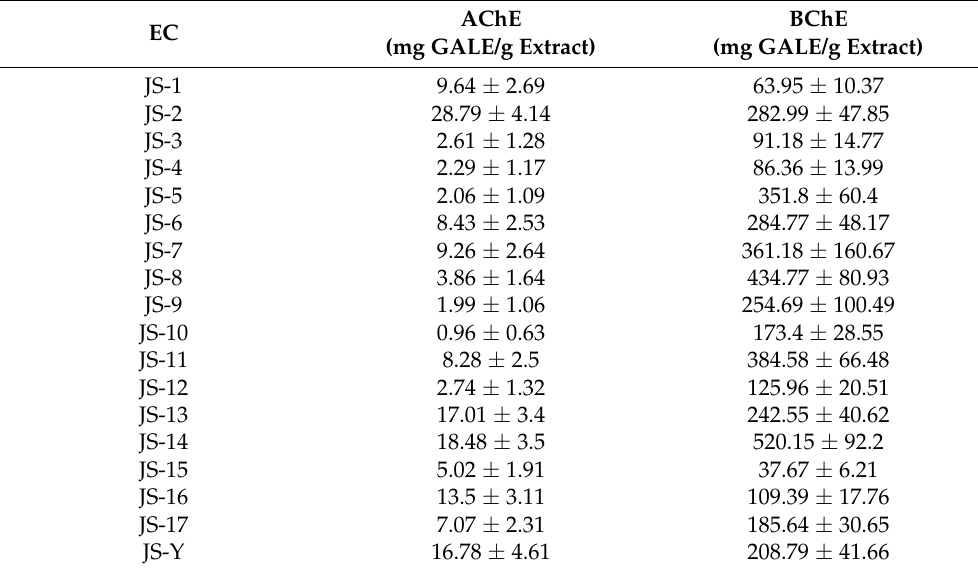
Table 5. Anticholinesterase activity of J. sabina needle extracts under different extraction conditions. AChE EC (mg GALE/g